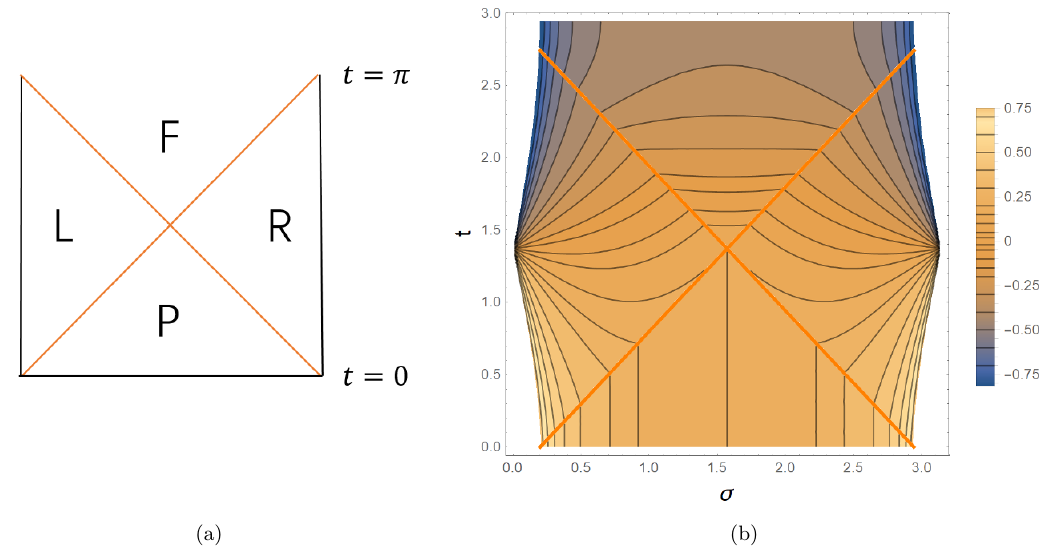
Figure 5 . (a) The two shock waves (orange lines) divide the bulk into four regions, which we denote as L (left), R (right), F (future), P (past). (b) The contour plot of the dilaton pro(cid:12)le for t > 0. In the plot, we choose the parameters (cid:15) = 0 : 1 ; (cid:14) = 0 : 2. The orange lines denote the shock 4 (cid:25)